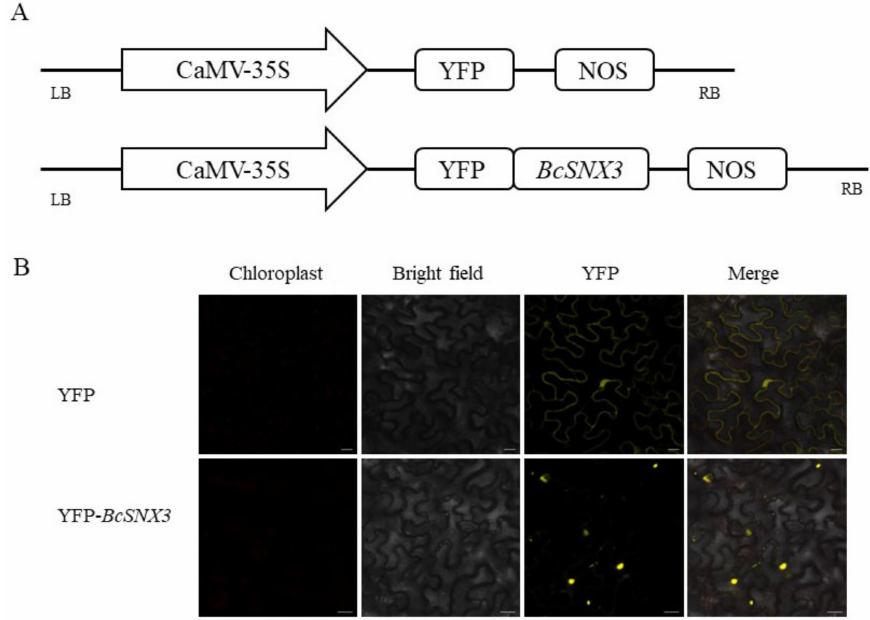
Figure 2. BcSNX3 is localized to the nucleus. ( A ) The construct of 35S: YFP and 35S: YFP- BcSNX3 . NOS: nopaline synthase gene. ( B ) Transient expression of 35S: YFP- BcSNX3 fusion protein in tobacco. 35S: YFP was used as a control. Fluorescence images of chloroplast, YFP, and merged were captured with confocal laser scanning microscopy and are displayed in red and yellow, respectively. Scale bars = 20 µ